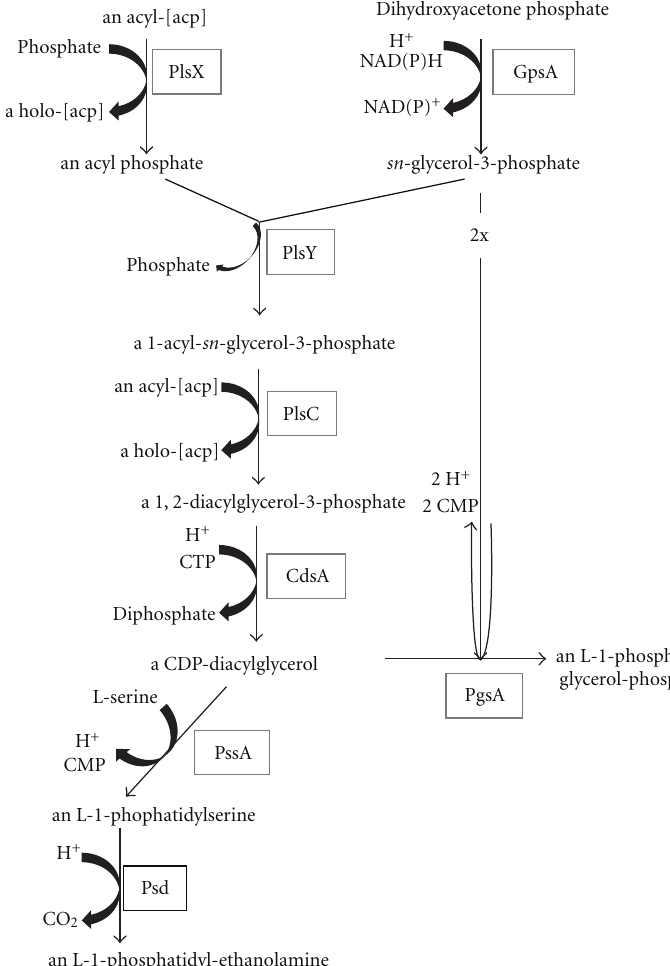
Figure 12: Key elements of the lipid